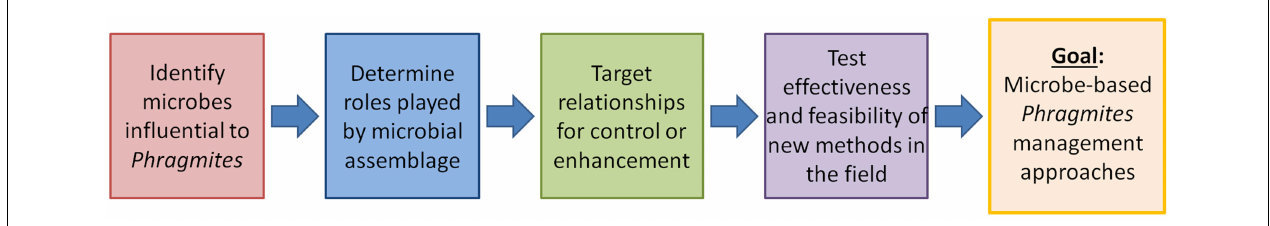
FIGURE 2 | Conceptual strategy for developing a microbial-based management approach to invasive plant species (e.g., Phragmites australis ).